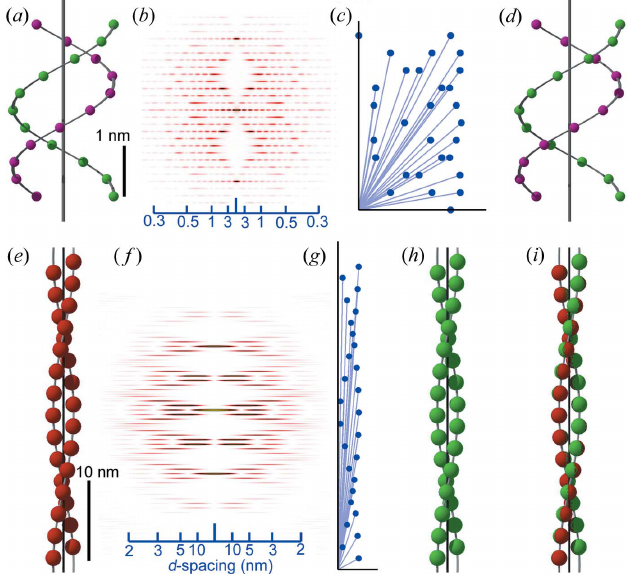
Figure 2 Application of the reconstruction method to helical structures. ( a ), ( e ) The starting model structures of double-stranded DNA (phosphate positions only) and the 28/13 helix of F-actin, respectively. The gray continuous helices and the central axes are shown for assisting purposes. ( b ), ( f ) Expected fiber diffraction patterns, consisting of helix-derived layer-line reflections. ( c ), ( g ) CAPs of the model structures. ( d ), ( h ) The 3D structures reconstructed from the CAPs alone. ( i ) A goodness of fit of the original and reconstructed F-actin structures, which depends on the magnitude of permissible errors set in the computer program. The scale bar in ( a ) also applies to ( c ) and ( d ), and the bar in ( e ) also applies to ( g ), ( h ) and ( i ). The values on the scale bars in ( b ) and ( c ) are d spacings (nm). Figs. S2 and S3 of the supporting information show how internal vectors in the 3D structures [( a ) and ( e )] are picked up in their CAPS [( c ) and ( g